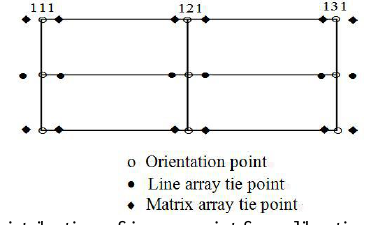
Figure 7. Distribution of image point for calibration camera